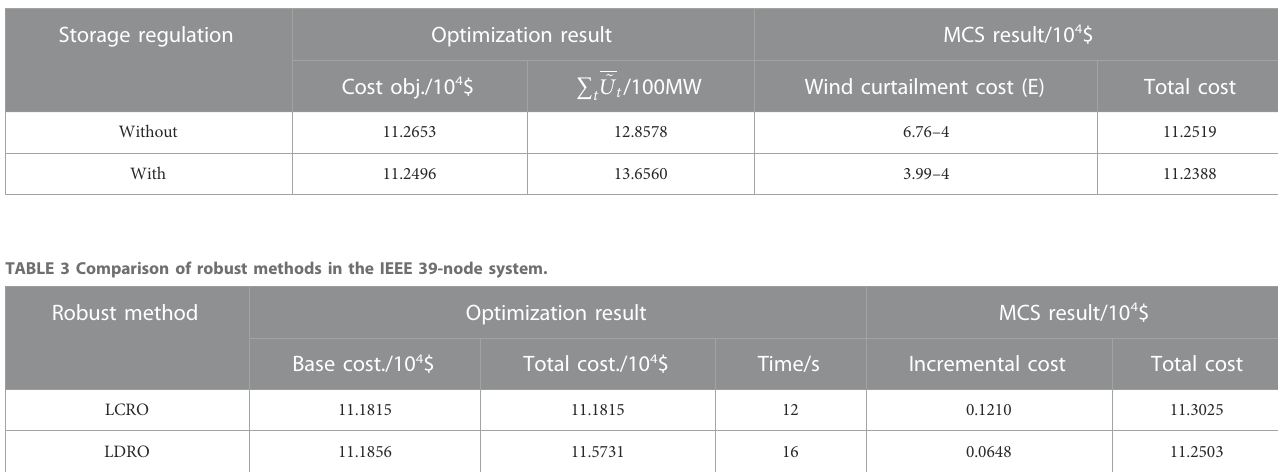
TABLE 2 Optimization and MCS results without and with the regulation of energy storages.